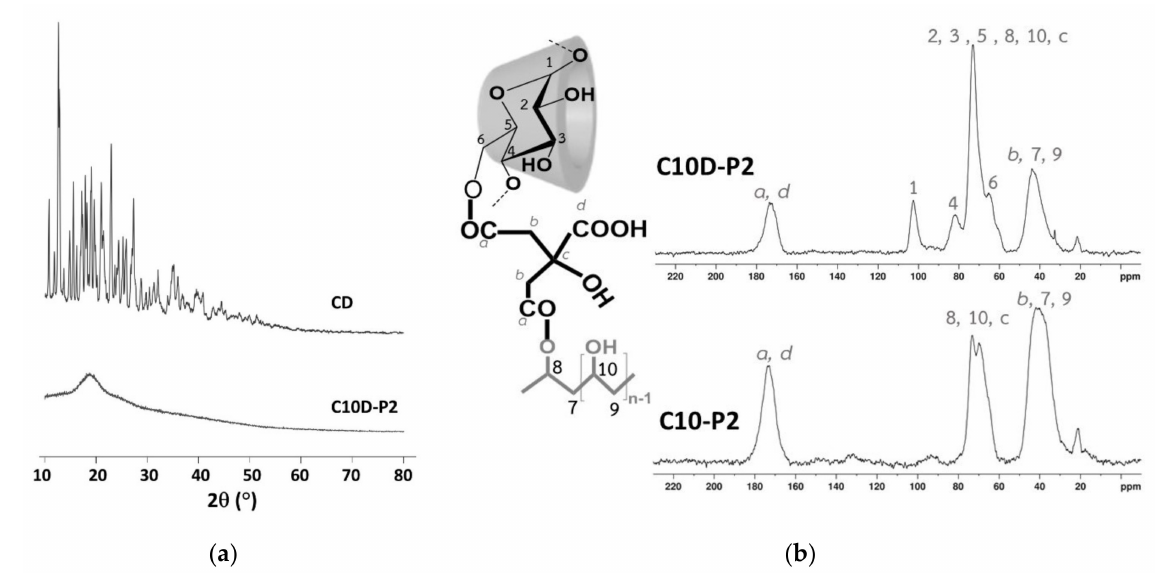
Figure 7. ( a ) XRD spectra of β -CD and C10D-P2 nanosponges; ( b ) 13 C NMR spectra of C10D-P2 and C10-P2